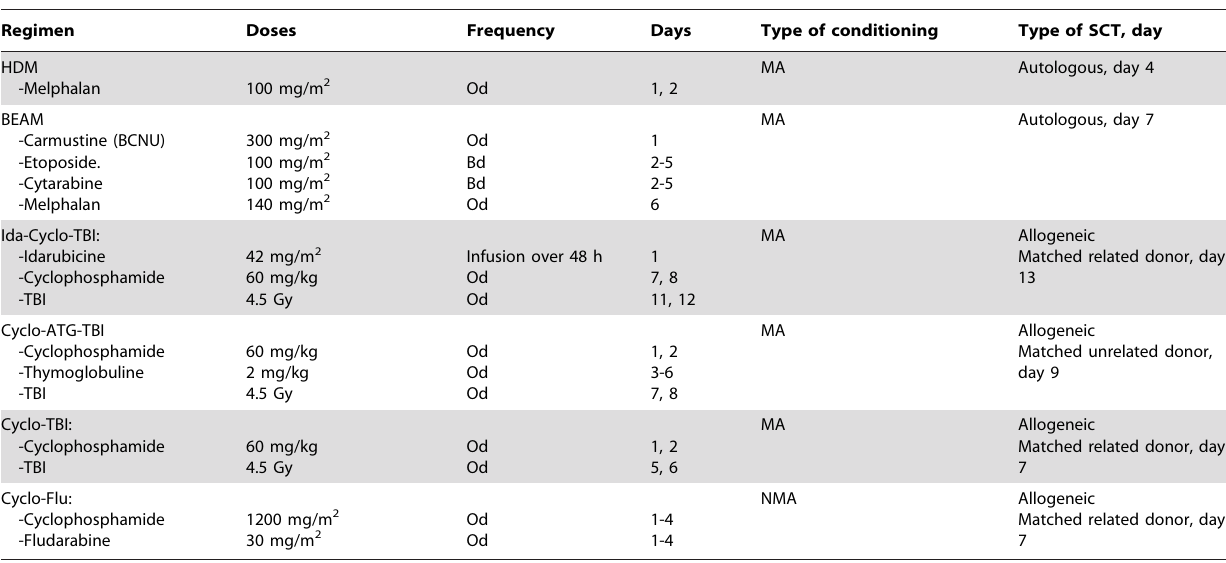
Table 1. Conditioning